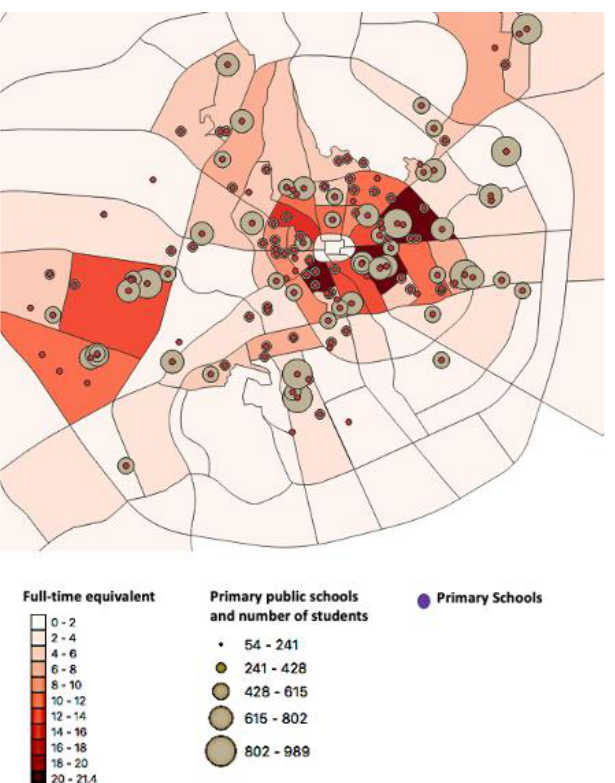
Figure 2. Model 1: a geographic model for school dental services (SDS) in Al-Madinah city presenting the distribution of full-time equivalent for SDS for each district.